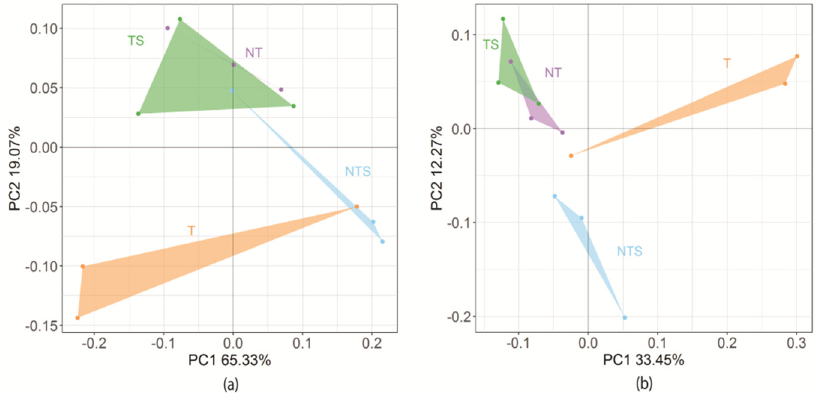
Figure 2. Summary of principal coordinate analysis of soil bacterial composition as affected by tillage and crop residue management treatments based on ( a ) the weighted UniFrac distance and ( b ) unweighted UniFrac distance. NT, no-tillage with all crop residue removed at harvest; NTS, no-tillage with crop residue chopped and spread evenly on the soil surface; T, conventional tillage with all crop residue removed at harvest; TS, conventional tillage with all crop residue chopped, spread evenly on the soil surface, and incorporated into the soil via